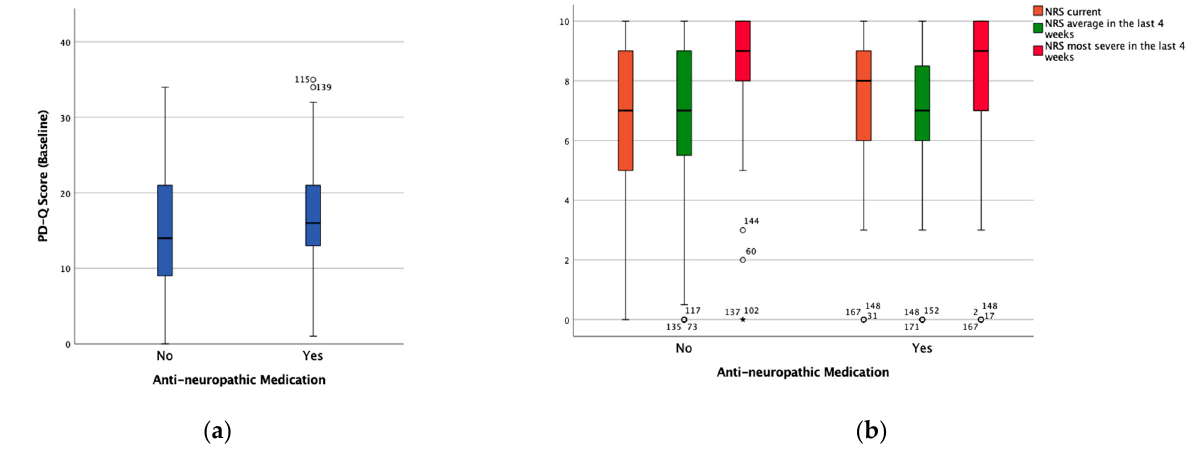
Figure 1. Boxplots showing the distribution of ( a ) the PainDETECT questionnaire (PD-Q) score and ( b ) the numeric rating scale (NRS) in the groups with (Yes) and without (No) anti-neuropathic medication at the baseline visit. ° and * represent outliers and extreme outliers respectively.